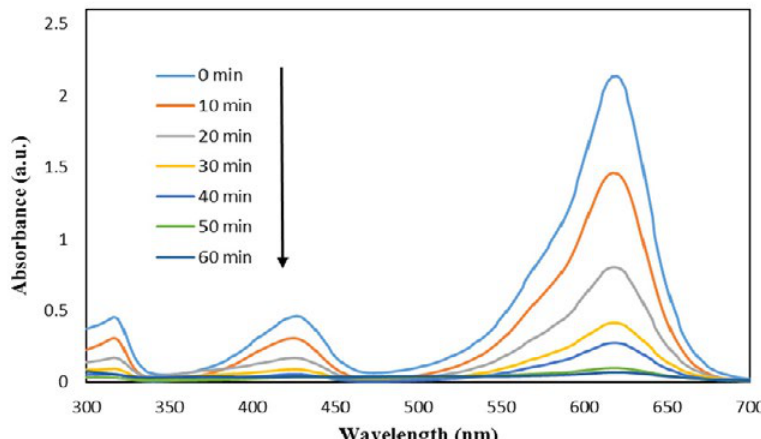
Fig. 6. Absorption spectra of MG aqueous solutions taken at various photocatalytic degradation times using MgFe